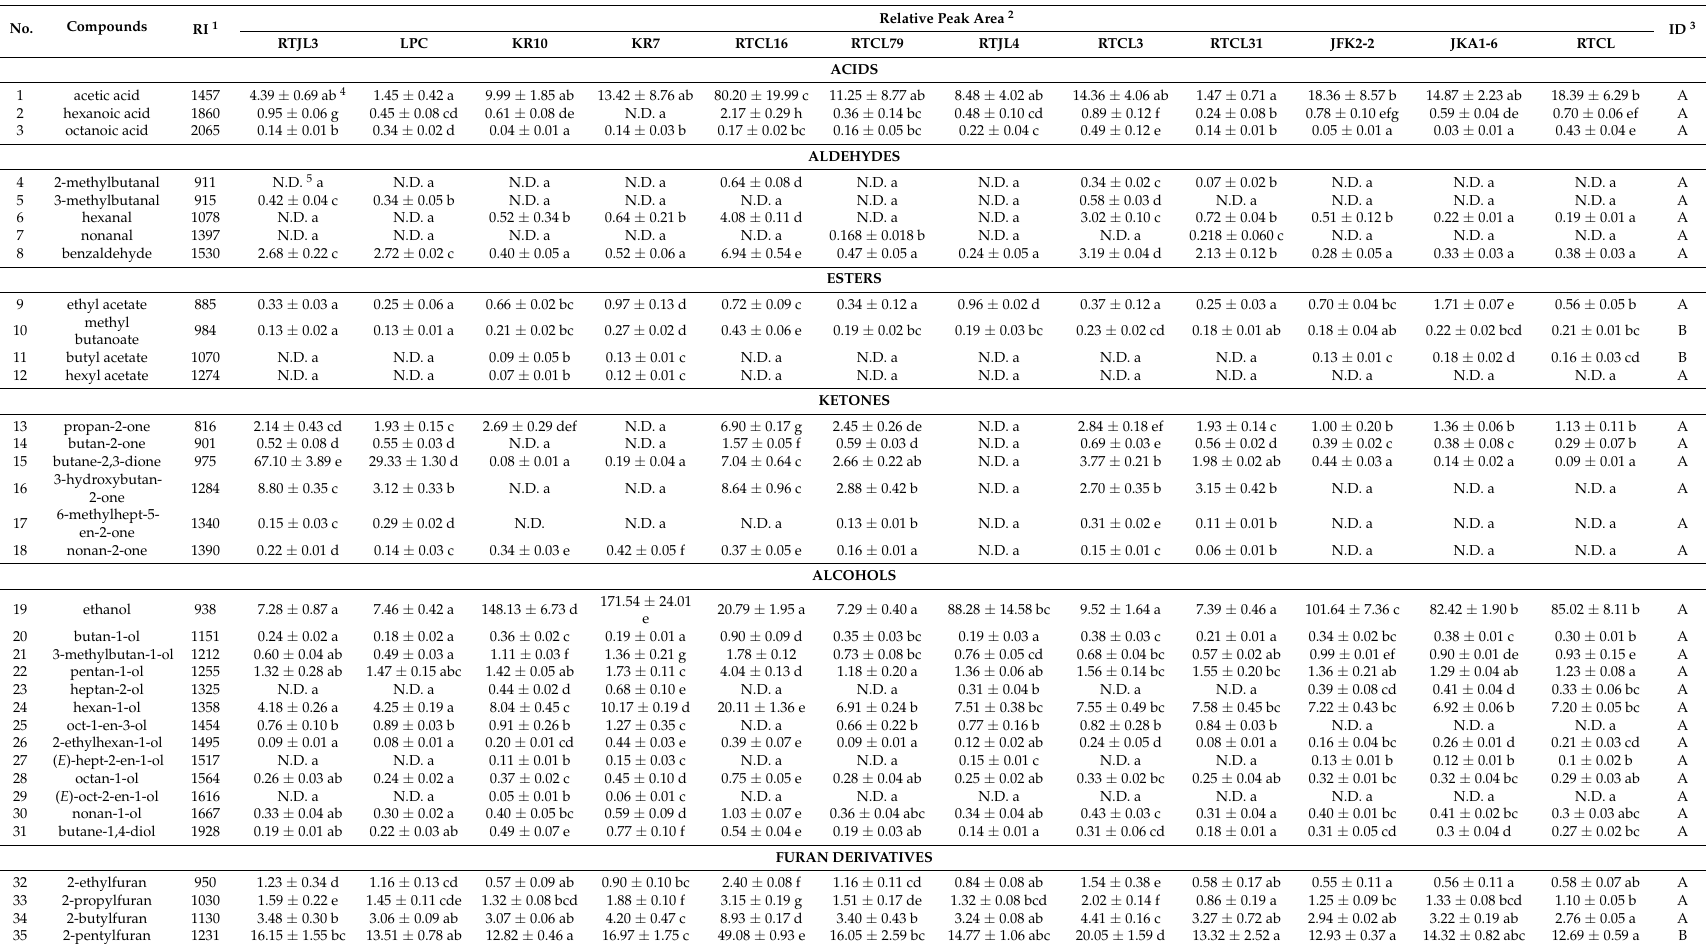
Table 1. Volatile compounds identified in fermented rice according to strains of lactic acid bacteria